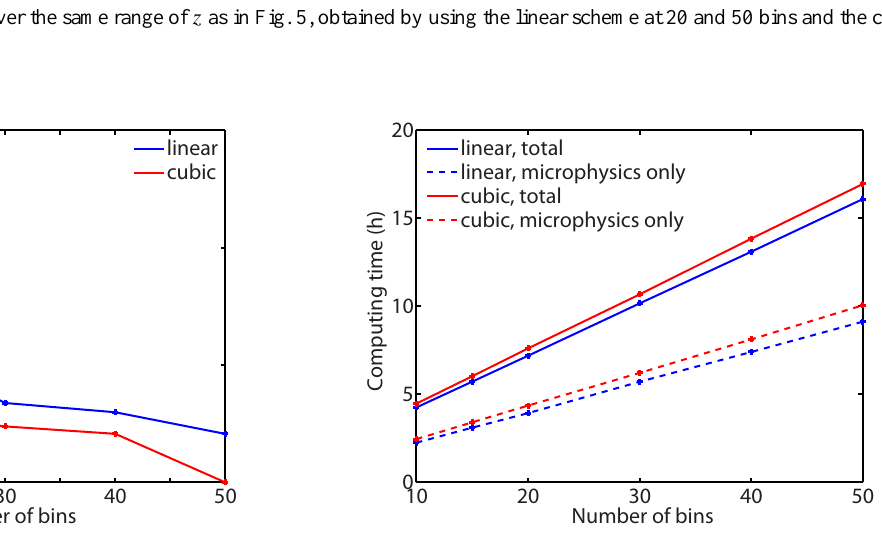
Fig. 9. Computing times required by the microphysics routine and by the whole model when the linear and cubic schemes are